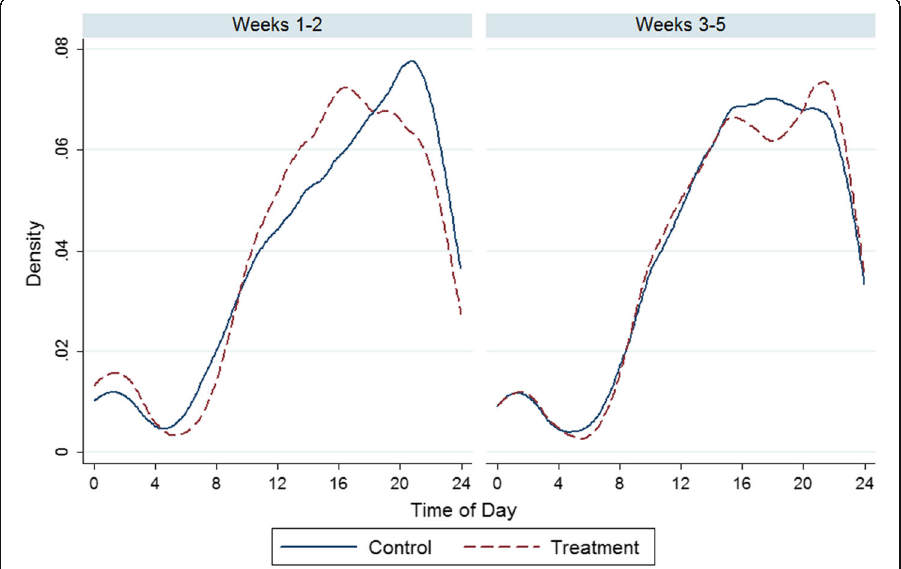
Fig. 11 Time of course interactions, control and treatment students, first and second weeks (left panel) and third through fifth weeks (right panel) of 5-week Physics course. Figure based on data and analyses in